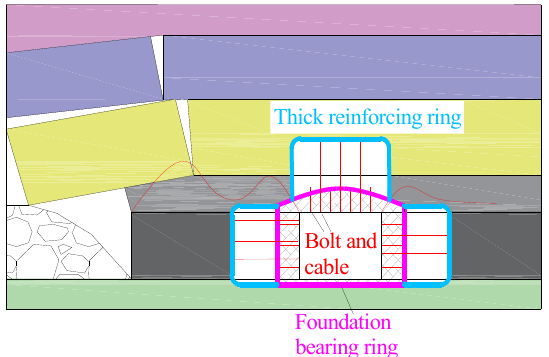
Figure 9. Surrounding rock-bearing structure after reinforcement and support with anchor cable.